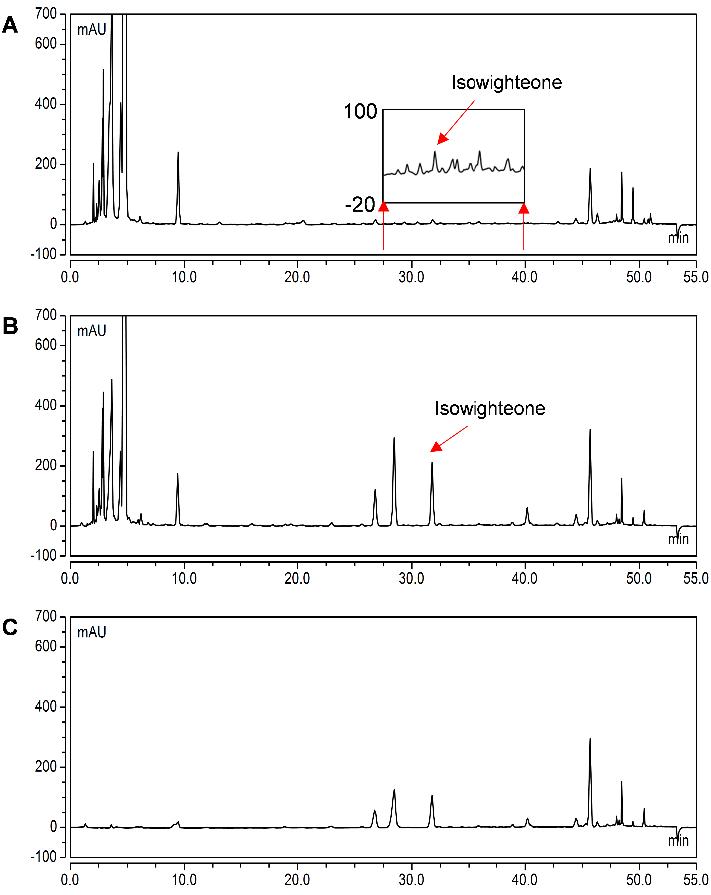
Figure 6. Comparison of isowighteone yield in hairy root tissues of 12-day-old pigeon pea hairy roots. HPLC chromatogram of ( A ) Non-elicited hairy root tissue extracted using 70% ethanol; ( B ) 144 h-elicited hairy roots extracted using 70% ethanol; and ( C ) 144 h-elicited hairy roots extracted using ethyl acetate. All chromatograms were monitored at 260 nm.